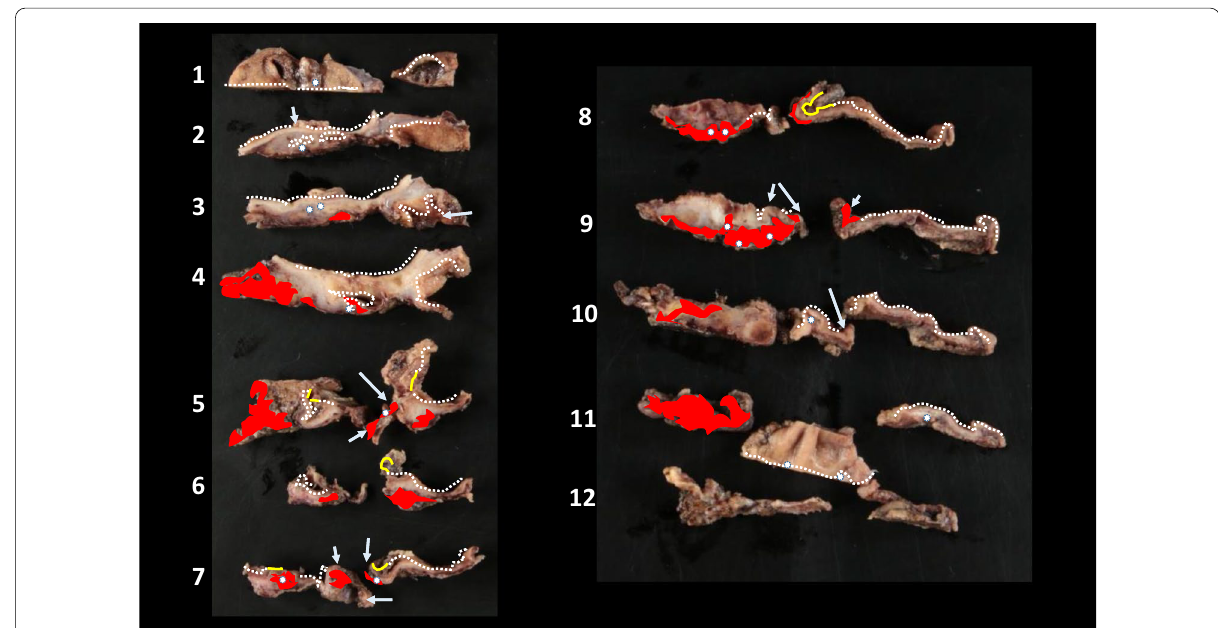
Fig. 5 Sequential sections of resected specimen with serial number. White dotted lines indicate non-tumoral epithelium. The CIS (yellow lines) and the hemorrhage sites (red areas) including the ulceration sites (white arrow) are distant. Embolic material (white spot) is observed in the hemorrhage site, and an ulcer and superficial vascular aggregates are observed at the sites irrelevant to the CIS